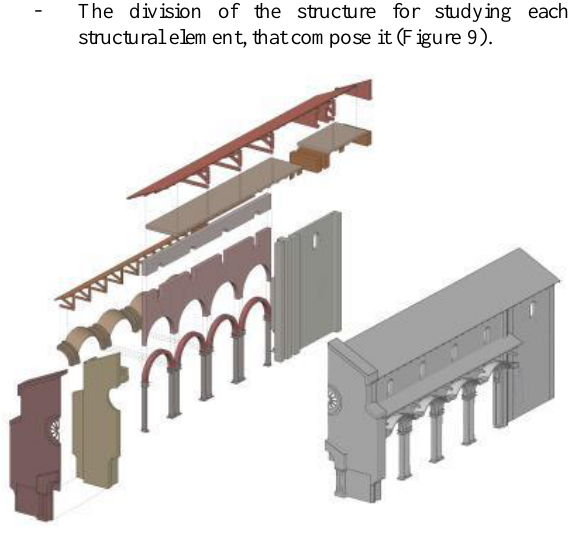
Figure 9. 3D exploded view of the analyzed system